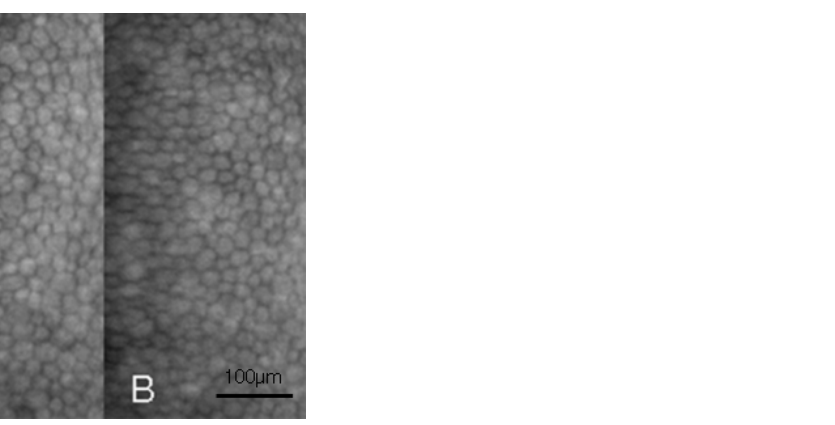
Figure 3. The clear cornea appearance with phakic intraocular lenses one week postoperatively. ( A ) The external eye image of right eye. ( B ) The external eye image of left eye.